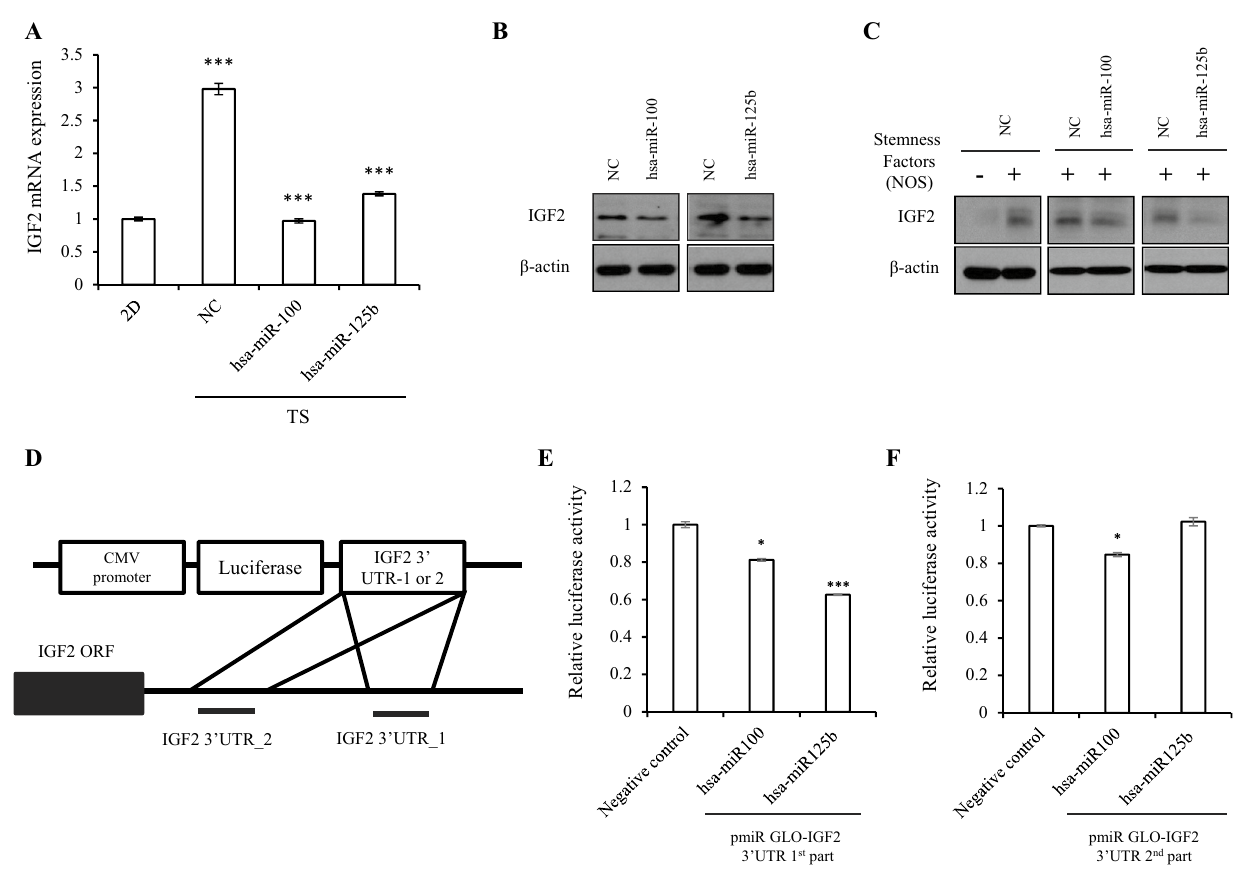
Figure 4. IGF2 is the target gene of miR-100 and miR-125b. ( A & B ) IGF2 mRNA levels ( A ) and protein levels ( B ) confirmed by qRT-PCR and immunoblots after treatment of miR-100 and -125b mimic. ( C ) Hep3B cells co-transfected with miR-100, -125b mimic (50 nM), and the stemness factor (NANOG, OCT4, and SOX2) for 48 h. Blots were cropped to show specific bands. (D) Schematic description of the miR-100 and -125b binding sites within IGF2 3 ′ UTR. (E–F) Luciferase activity of Hep3B cells co-transfected with miR-100 or -125b mimic and negative control or plasmids containing IGF2 3 ′ UTR 1st region ( E ) or 2nd regions ( F ). For qRT-PCR, relative expression was calculated using 18 s expression as an internal control. Immunoblots used β-actin as a loading control. The average (column) ± SD (bar) is indicated ( * p < 0.05, *** p <